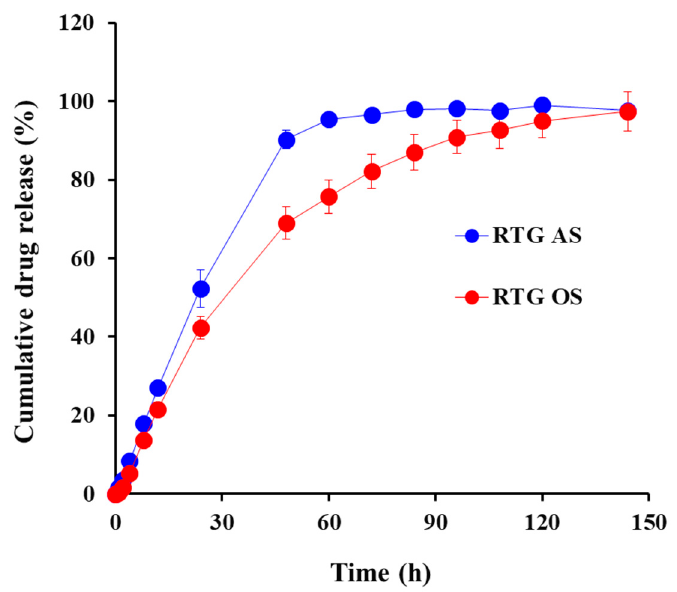
Figure 5. Plasma concentration-time profiles of RTG following SC injection of RTG AS ( ) and RTG OS ( ) in rats (30 mg/kg as RTG). Notes: Data are expressed as mean ± SD ( n = 5). The dashed line (--) indicates the limit of quantitation (LOQ). The plasma concentration of RTG after AS or OS injection was below the LOQ after 28 and 7 days, respectively. Table 4. Pharmacokinetic parameters of RTG following SC injection of drug suspensions in rats (30 mg/kg as RTG).